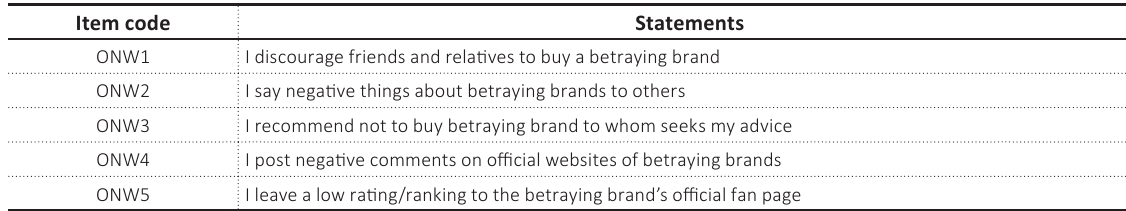
Table A3. Negative online word of mouth (NOW) Item code